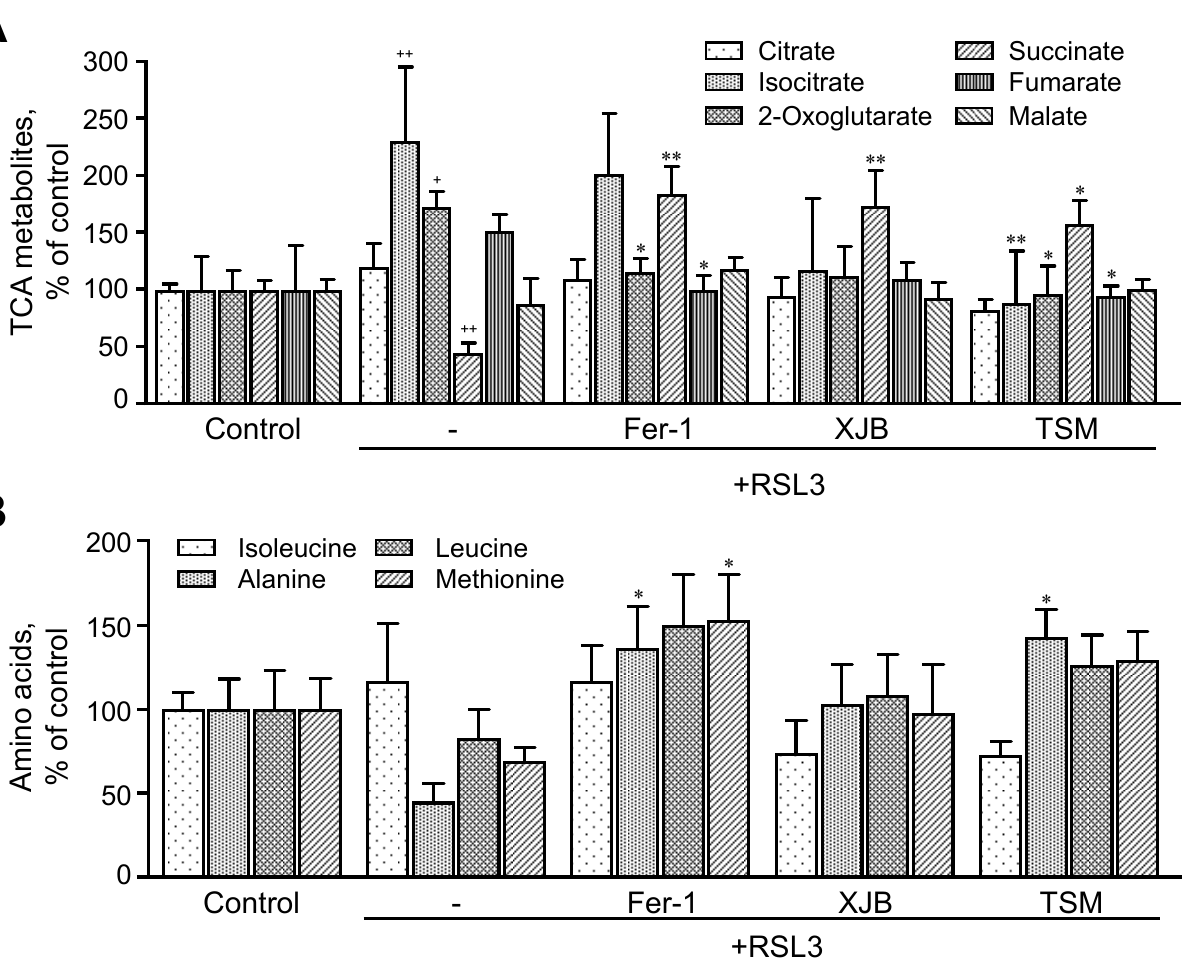
Figure 6. TCA metabolites and amino acids levels after ferroptosis. The TCA metabolites ( A ) identified were citrate, isocitrate, 2-oxoglutarate, succinate, fumarate, and malate. The amino acids represented are isoleucine, alanine, leucine, and methionine ( B ). Data are presented as a percentage of the control group. + p < 0.05, ++ p < 0.01 vs. control; * p < 0.05 and ** p < 0.01 vs. RSL3. n = 4–6 per